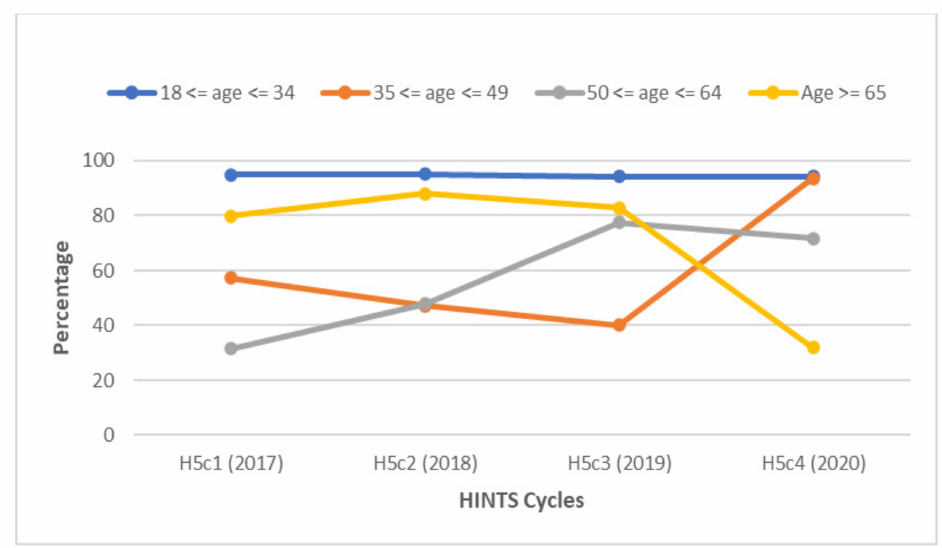
Figure 5. Awareness of HPV among gay and bisexual males according to age group between 2017 and 2020. The highest percentage of GBM with knowledge about HPV were between the ages of 18 and 34. Smaller proportions of GBM between the age of 35 and 64 were aware of HPV from 2017 to